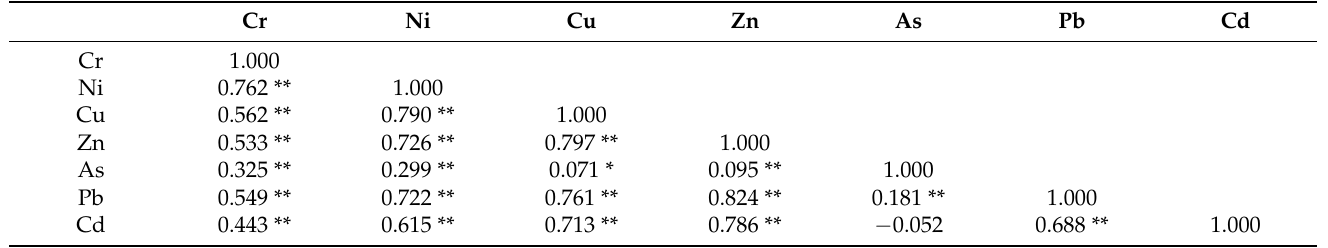
Table 6. Spearman correlation analysis of seven heavy metals in soils of